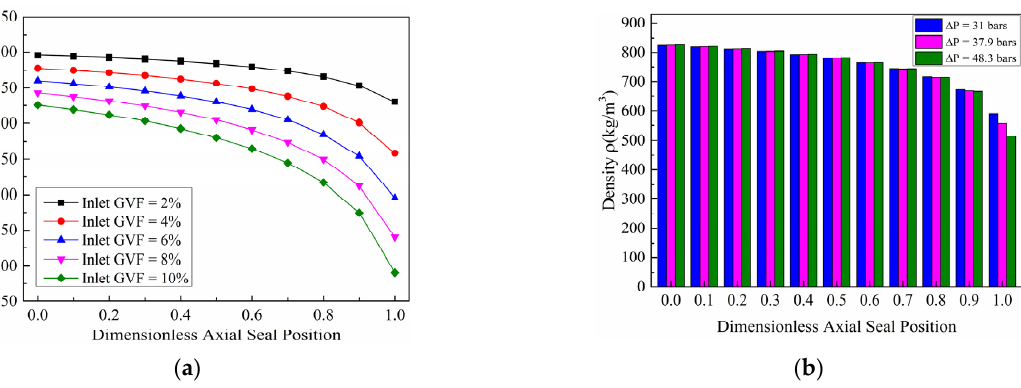
Figure 5. GVF distribution characteristics along the axial direction at specific regions. ( a ) Schematic diagram of the three specific regions, ( b ) GVF increment versus inlet GVF in regions 1, 2, and 3.